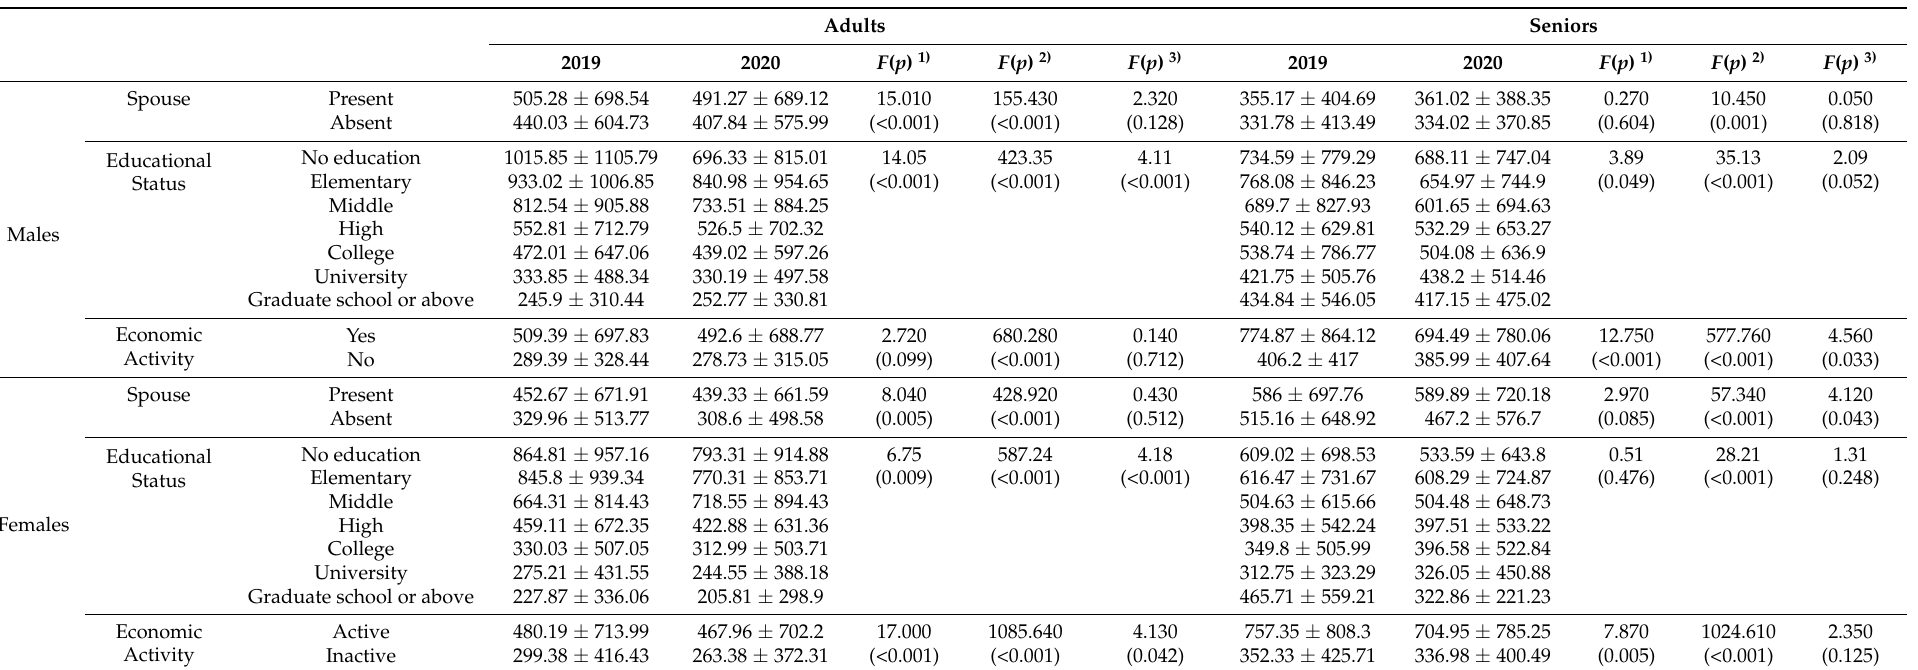
Table 3. Differences in physical activity (moderate-intensity) by general characteristics of subjects (2019–2020). Adults